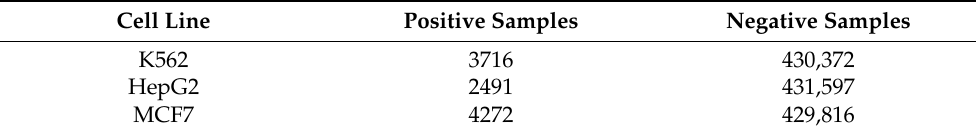
Figure 2. Determination of positive and negative samples. In the training and evaluation workflow, in vitro G4 data (G4-seq) are used as the candidate dataset. In vivo G4 experimental data (G4 ChIP- seq or G4 CUT&Tag) are used to split positive (active G4s) and negative (inactive G4s) samples. More specifically, a candidate G4 is tagged as a positive sample if it overlaps with an in vivo G4 peak and the length of the overlapped region is greater than 10% of this candidate entry’s length. Table 1. Positive/negative samples of different cell lines.